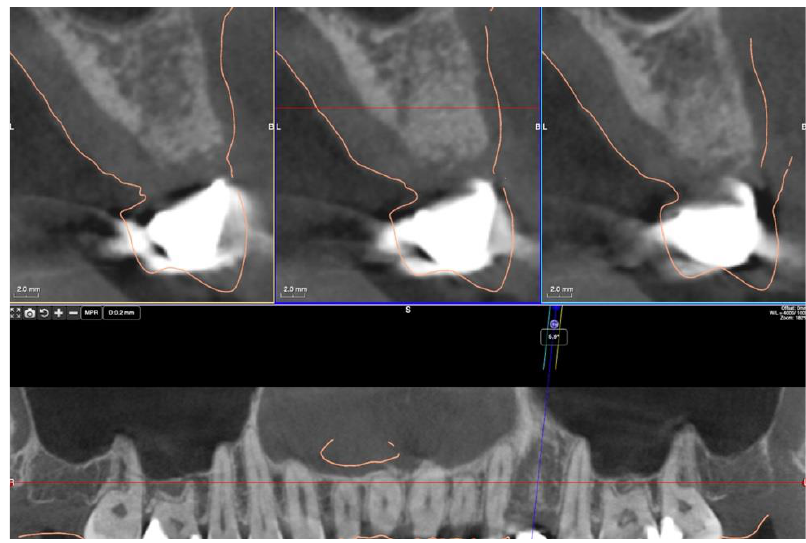
Figure 6. CBCT view six months post-augmentation before implantation in region 24.